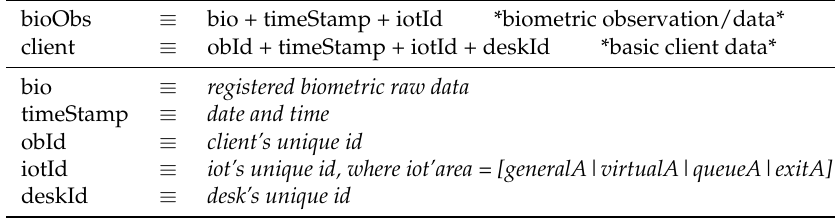
Table 2. The structure of basic messages transferred within the system. The meaning of particular elements is intuitive, whereby “timeStamp” means a time stamp, a certain moment in time, when biometric readings were performed. (Symbols for the table: “ ≡ ” is defined as; “=” is equal to; “+” conjunction; “[ ]” the choice of one possibility; “|” separator of disjoint choice related to [ ]; asterisks are for